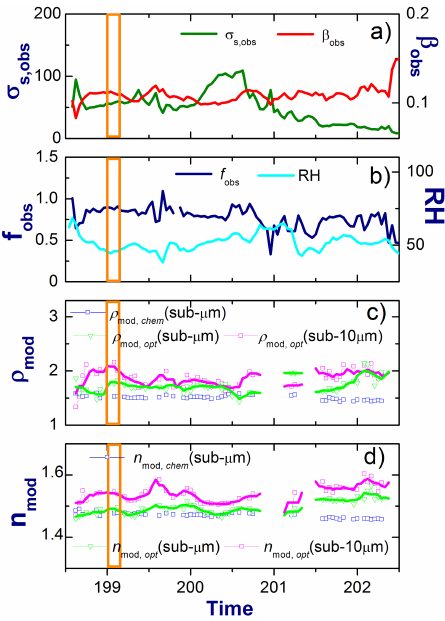
Figure C1. The same as Fig. 6 but for selected dry period (52 points, RH = 51.9 ± 5.8). The vertical orange bar represents a sub-period where the optical properties of dry particles (Fig. C1) are compa- rable with those obtained for their wet counterparts (Fig. C2), but values of the RH are very different.